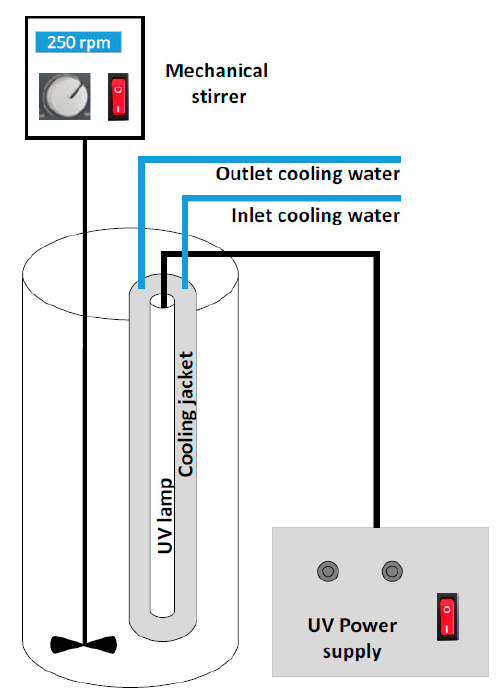
Figure 1. Photo-Fenton set-up.